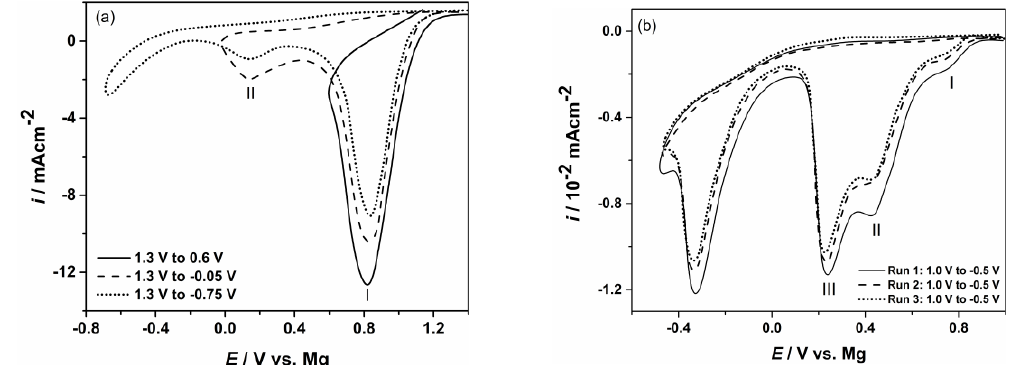
Figure 1. Typical cyclic voltammograms recorded on Au electrode obtained with scan rate 10 mV/s in: ( a ) magnesium/ammonium nitrate eutectic mixture melt at 400 K; ( b ) nonaqueous magnesium/ammonium nitrate eutectic mixture melt at 460 K.